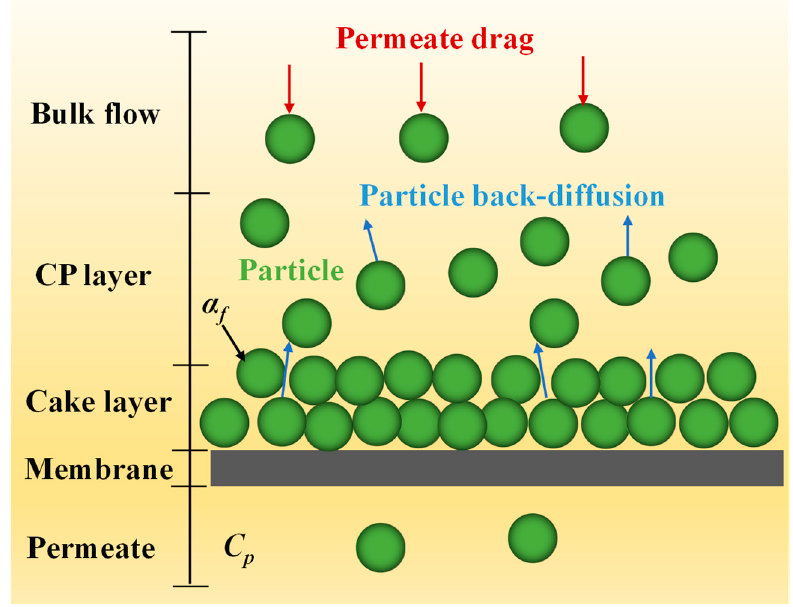
Figure 2. Schematics of cake formation during membrane filtration.